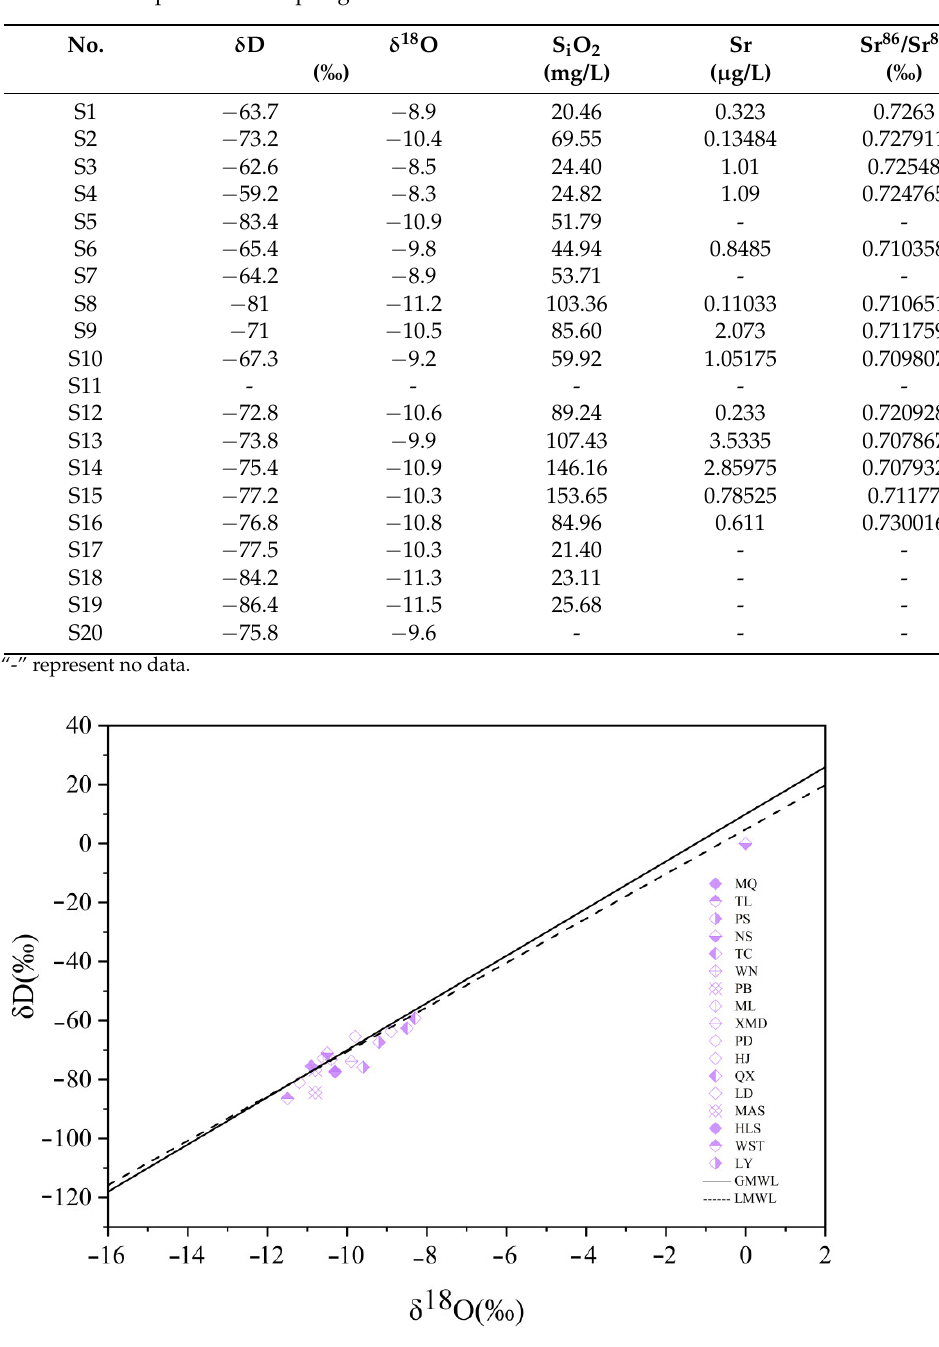
Figure 3. Stable oxygen and hydrogen isotope of the 20 hot springs and their correlations with GMWL and LMWL. LMWL: δ D = 8.41 δ 18 O + 16.72 Table 2. The data of Hydrogen and oxygen isotope compositions, silicon dioxide, strontium, and strontium isotopes from hot springs.